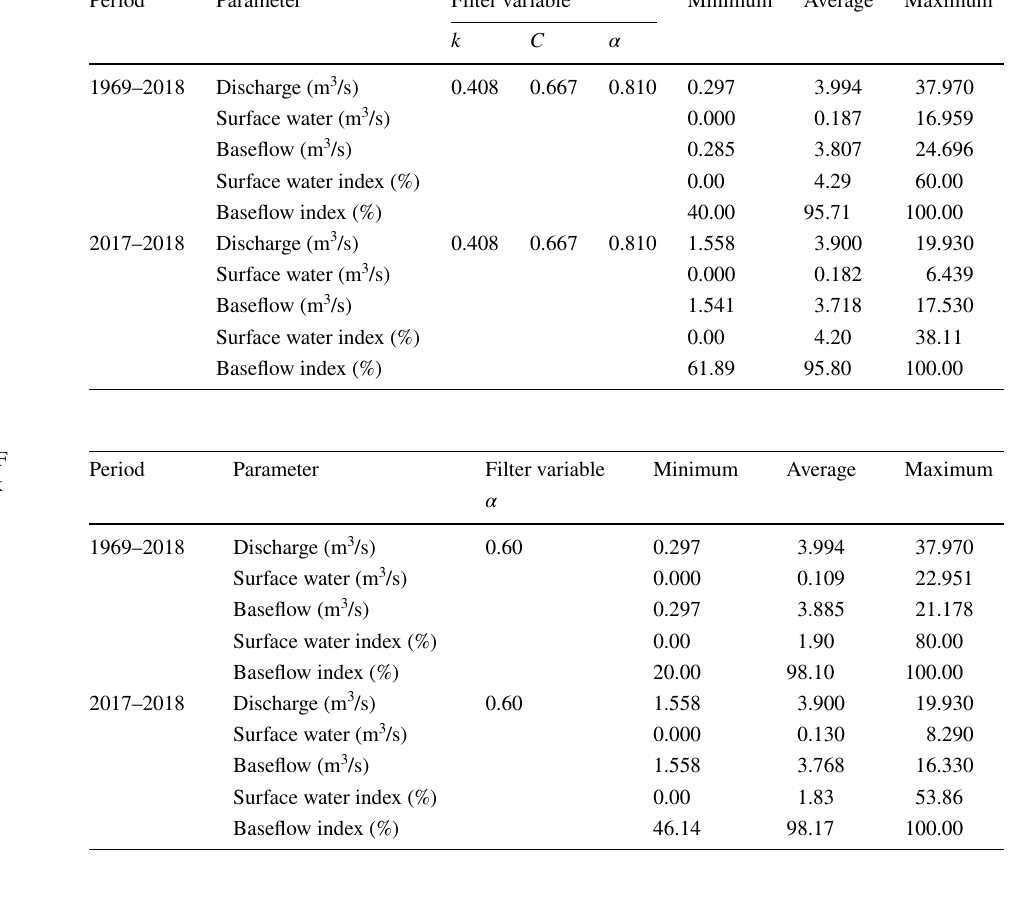
method—three-parameter algorithm